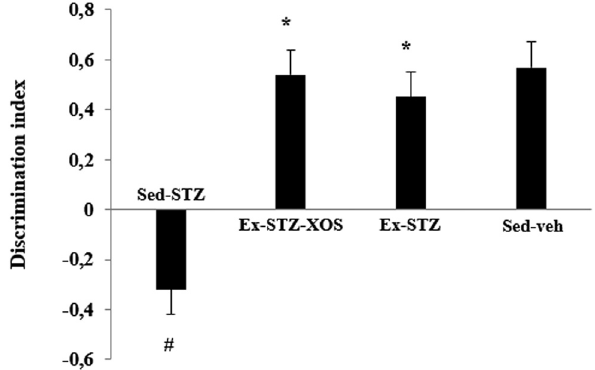
Figure 6: E ff ect of XOS and/or the aerobic training on the results from the ORT. * Signi fi cant di ff erences in comparison to Sed - STZ and # signi fi cant di ff erences in comparison to Sed -